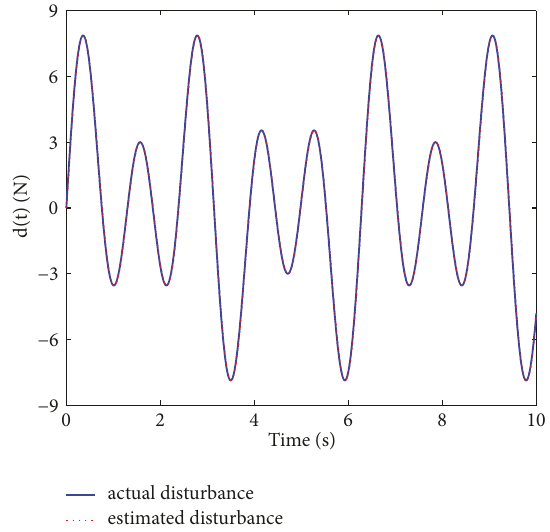
Figure 6: External disturbance tracking.